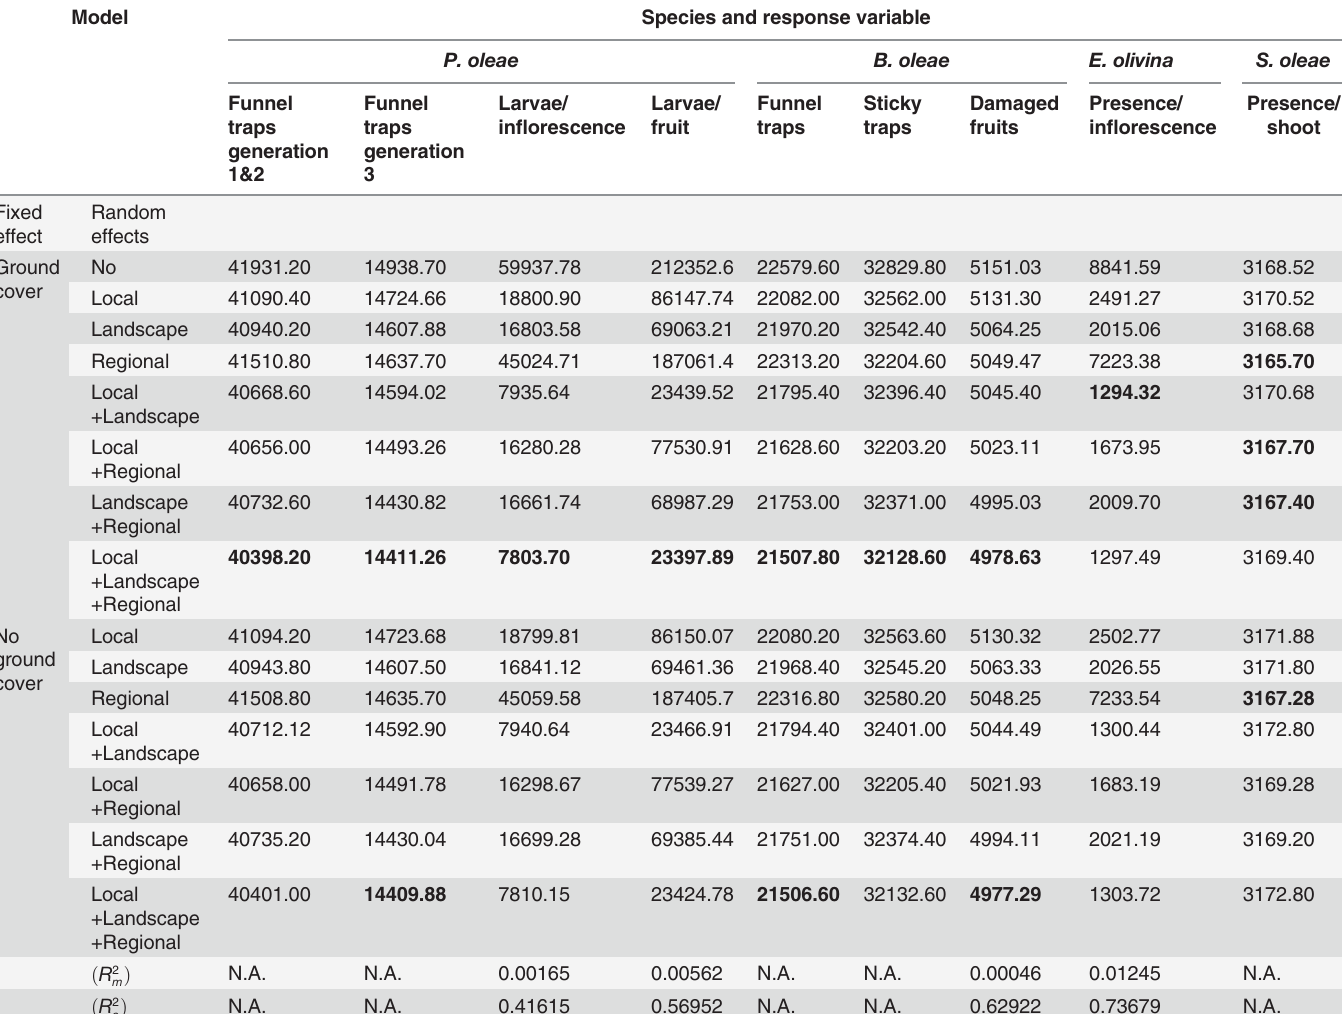
Table 2. Comparison of alternative models (using AIC c ) for the response variables tested in the study.